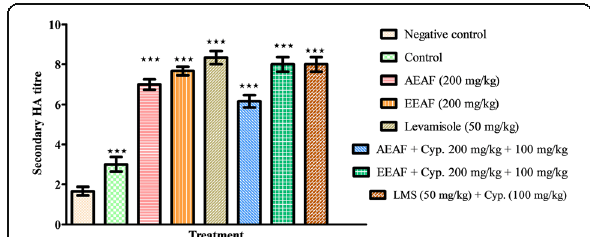
Fig. 10 Effect of AEAF and EEAF on delayed type of hypersensitivity (DTH) in mice. Results were expressed as mean ± SEM, ( n = 6). Statistical analysis was performed with one-way analysis of variance (ANOVA) followed by Tukey-Kramer multiple comparison test. # P < 0.05, ## P < 0.01 as compared with NC. P value less than < 0.05 was considered to be statistically significant. * P < 0.05, ** P < 0.01 and *** P < 0.001, when compared with control